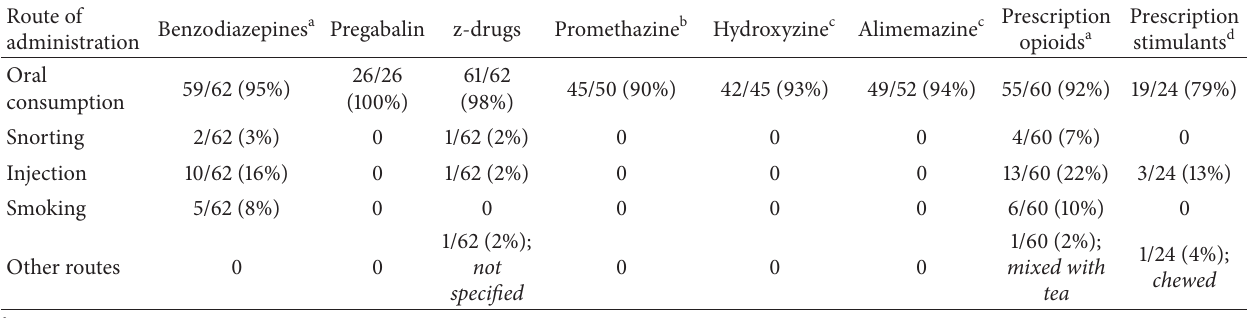
Table 4: Administration of prescription drugs (not mutually exclusive) among opioid maintenance treatment patients. Presented as n (% of lifetime users of each prescription drug).